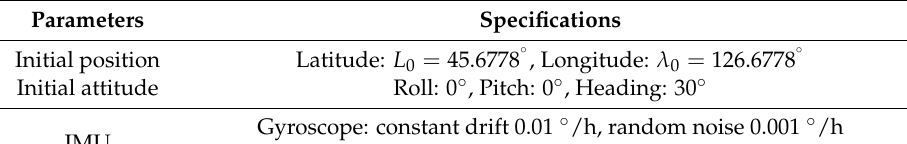
Table 1. Specifications of simulation parameters.